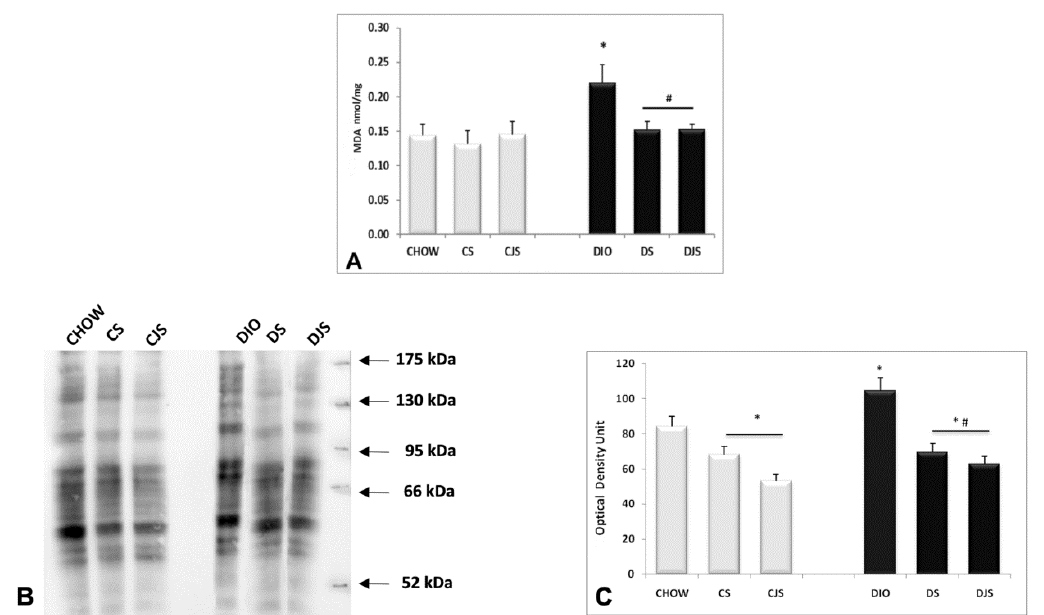
Figure 7. Concentrations of ( A ) malondialdehyde (MDA) in the liver expressed in nmol/mg of tissue. ( B ) OxyBlot in the liver homogenates and ( C ) the graph reports the values of optical density measured in the arbitrary optical density unit. CHOW—control rats with standard diet; CS—CHOW plus tart cherry seeds; CJS—CHOW plus tart cherry seeds and juice; DIO—diet-induced obese rats; DS—DIO plus tart cherry seeds; DJS—DIO plus tart cherry seeds and juice. Data are the mean ± SEM. * p < 0.05 vs. CHOW rats; # p < 0.05 vs. DIO rats.